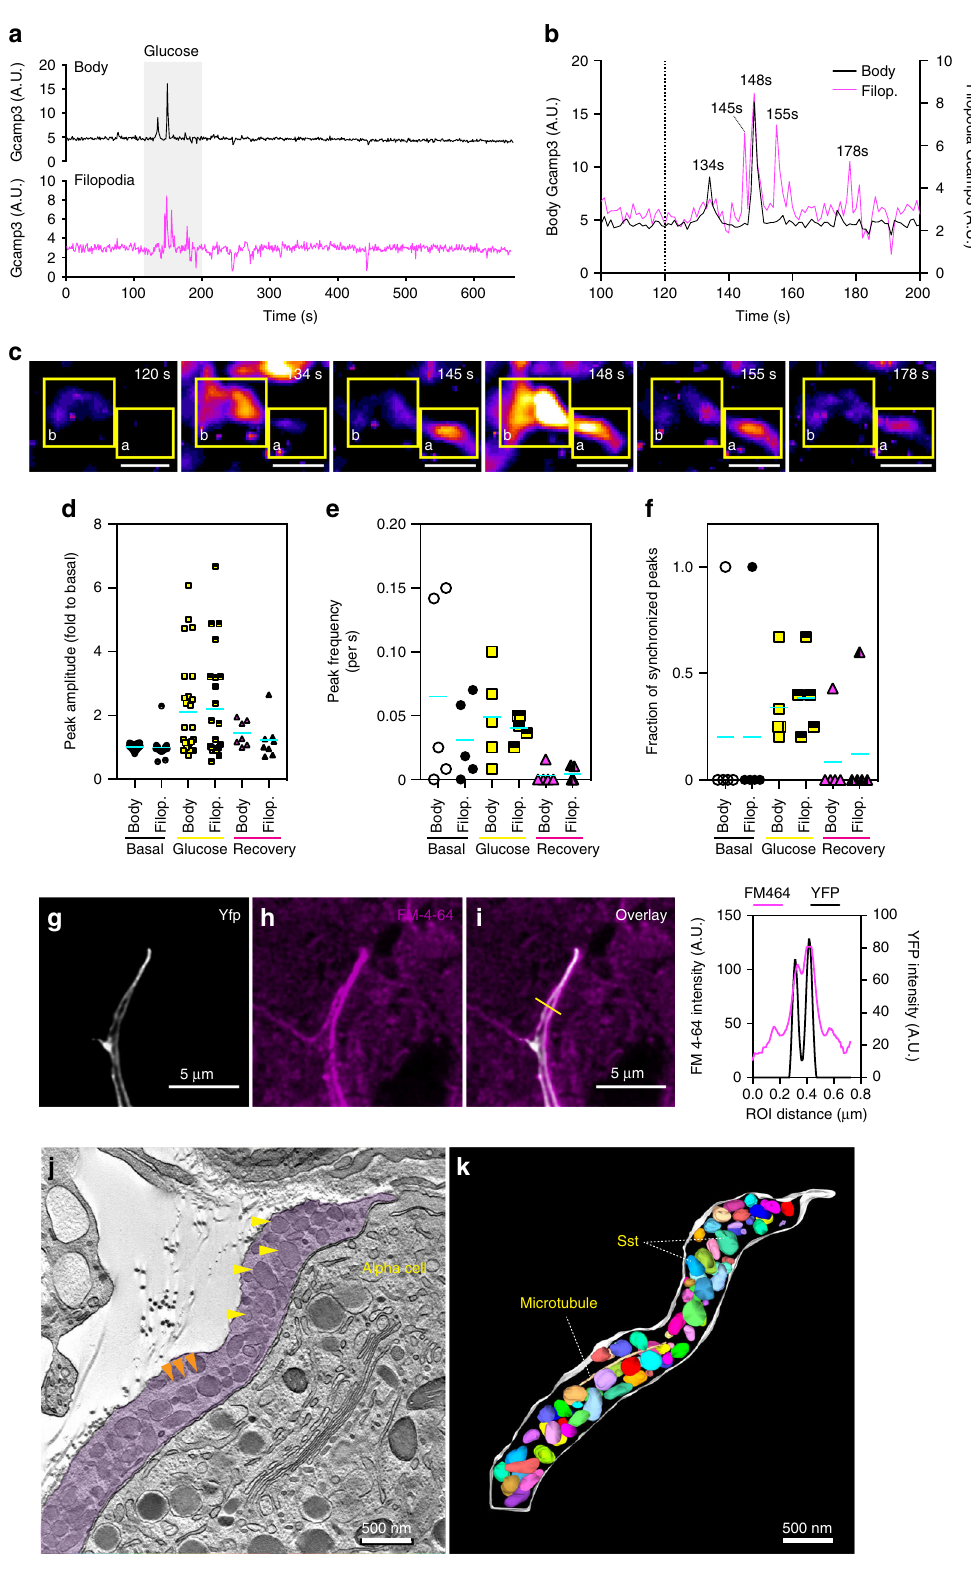
impairment of delta cell function and altered morphology. The timescale of delta cell dysfunction parallels that of beta cells under similar prediabetic conditions, where higher circulating insulin and somatostatin levels should occur due to both increased basal beta cell secretory activity 21 and a direct stimulatory effect of